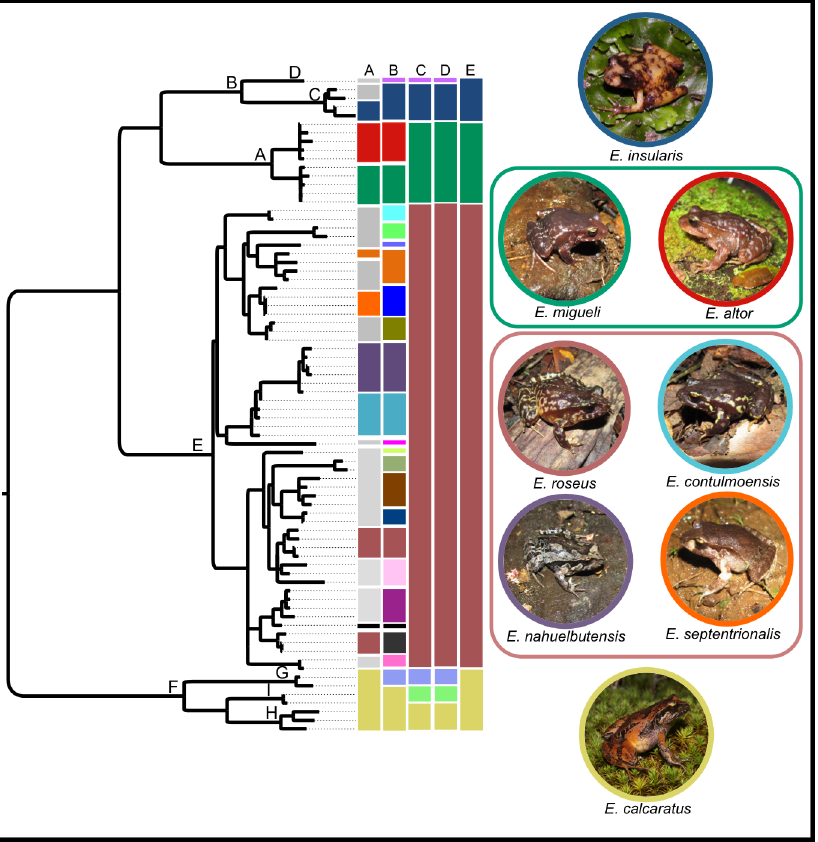
Fig 4. Candidate species of the Eupsophus roseus group, according to three species delimitation analyses. Candidatespecies obtainedwith each analysisare depictedas coloredboxes arrangedin columns: General Mixed Yule Coalescent (GMYC, column B), multi-rate Poisson Tree Process (mPTP, column C), Automatic Barcode Gap Discovery(ABGD; columns D, relaxed, and E, conservative results). Groupings obtained with each analysisare contrasted with the current taxonomy (columnA) and the maximum likelihoodtree used in mPTP. Cladeslabeledwith capitalletters are the same of Fig 3. Gray boxes in column A represent the undescribed populations includedin this study. Pictures of representativesof the eight previously recognized species of the roseus group are borderedwith the same colors used in all the columns. Pictures were enclosedaccordingto the favored taxonomic proposal (conservative ABGD). The small black boxes of columns A and B correspondto Eupsophus sp. 2 of Blotto et al.